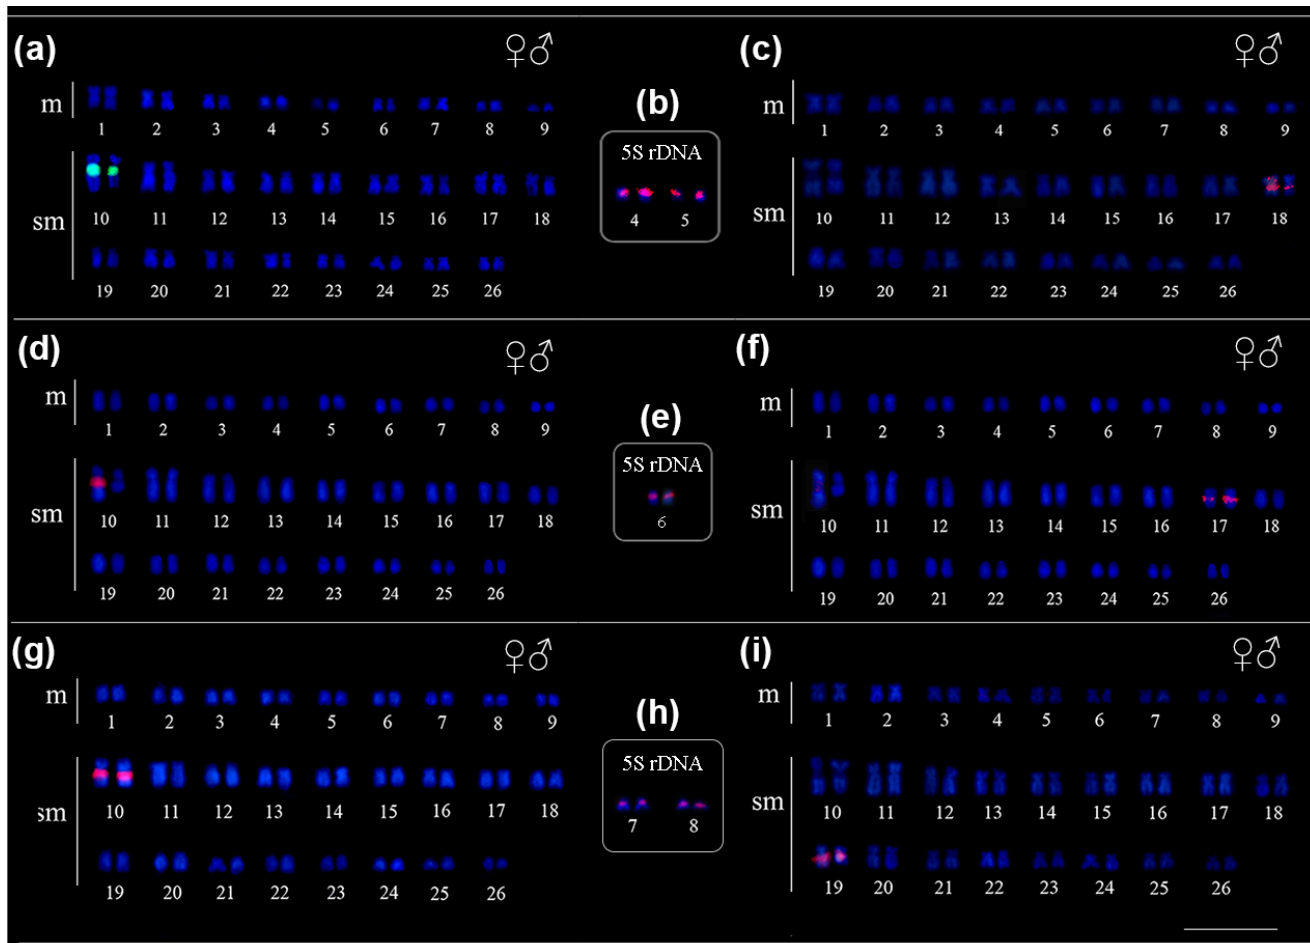
Figure 2. Fluorescence in situ hybridization indicating the physical location of rDNA and snDNA sequences in the karyotypes of Pseudacanthicus species . In ( a ) 18S rDNA, ( b ) 5S rDNA and ( c ) U2 snDNA in P. spinosus ; in ( d ) 18S rDNA, ( e ) 5S rDNA and ( f ) U2 snDNA in P. leopardus ; in ( g ) 18S rDNA, ( h ) 5S rDNA and ( i ) U2 snDNA in Pseudacanthicus sp. Hybridization signals were detected with FITC (green) and Cy3 (red), and chromosomes were counterstained with DAPI (blue).